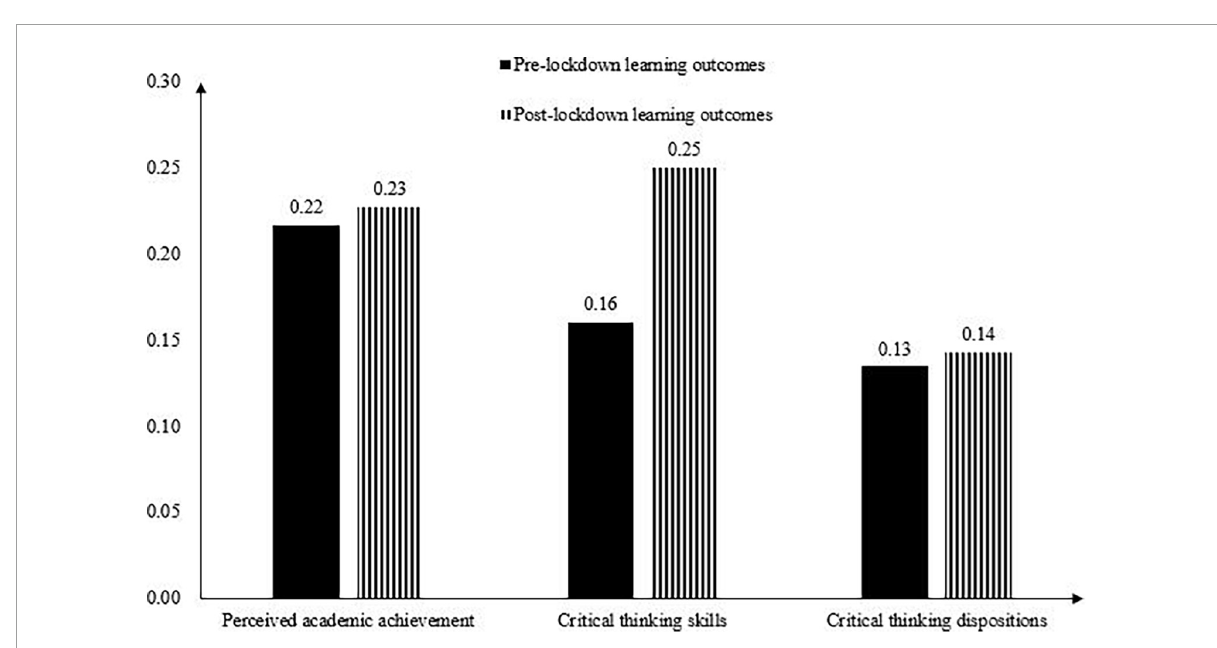
FIGURE2 Illustrations of variability of each learning outcome before and after the university